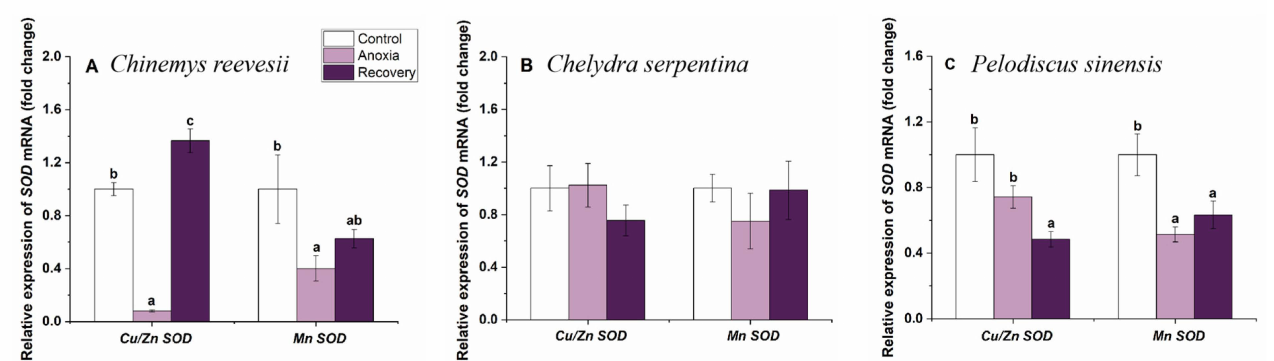
Figure 4. Changes of anoxia stress on related expression of SOD mRNA in the brain of C. reevesii ( A ), C. serpentina ( B ) and P. sinensis ( C ). Data are presented as mean ± SE. N = 8. Data with no common lowercase letters on the bar indicate significant differences between different groups ( p < 0.05).